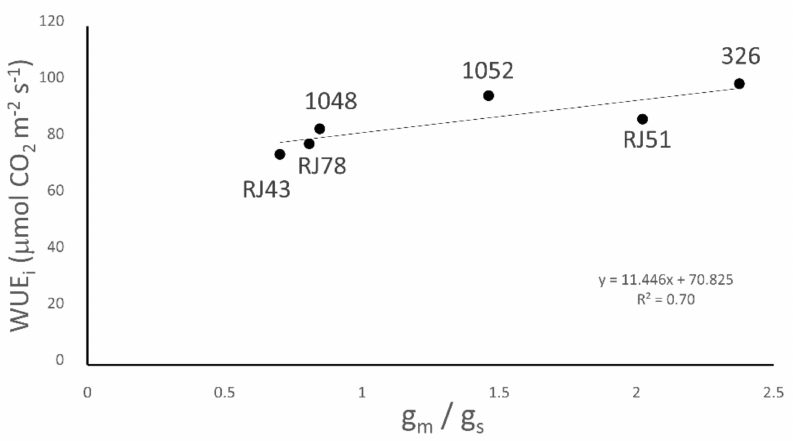
Figure 3. Relationship between the intrinsic WUE (WUE i ) and the mesophyll and stomatal conduc- tance ratio (g m /g s